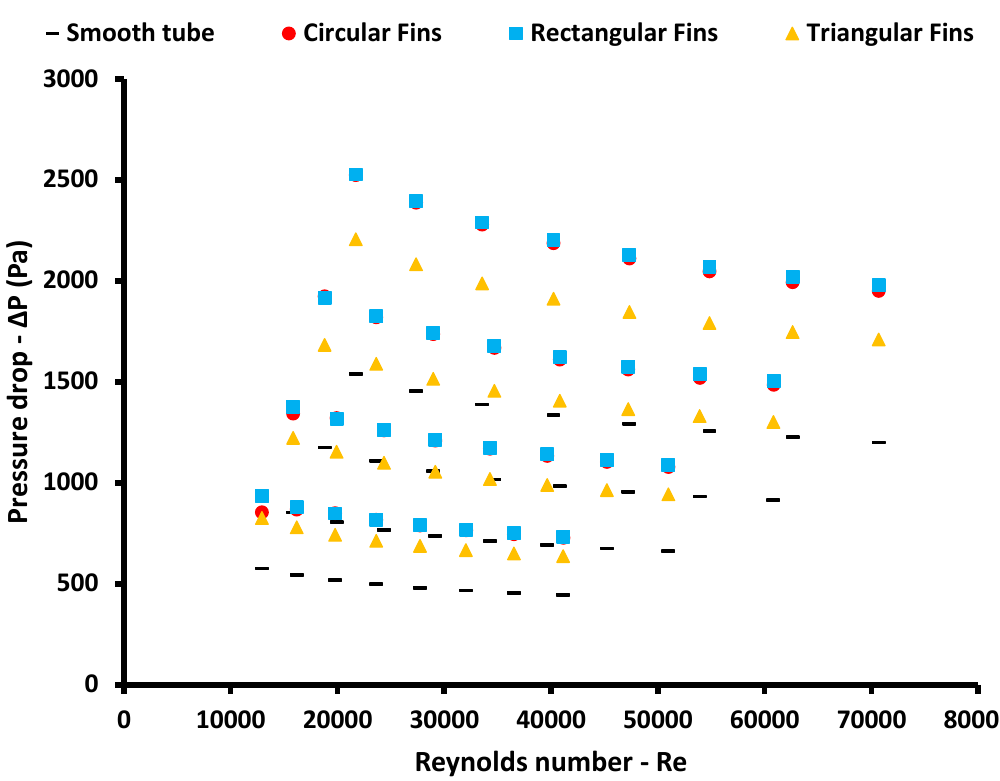
Figure 16. Friction factor in the examined cases for all the tubes.